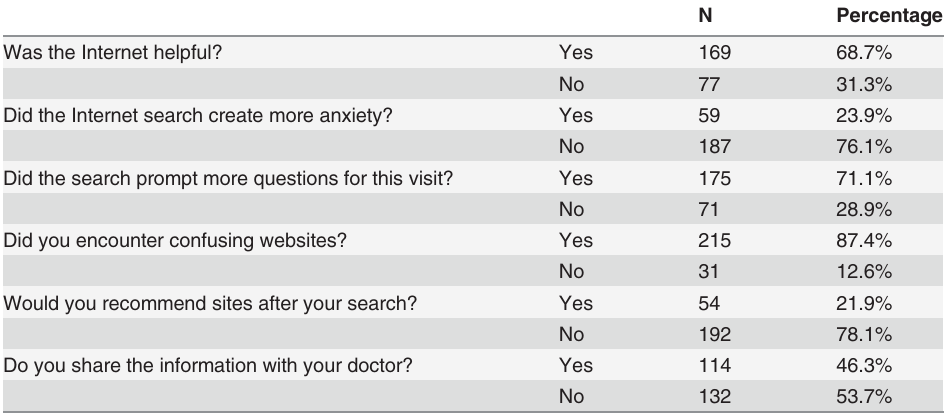
Table 3. Results of questions assessing the search experience of